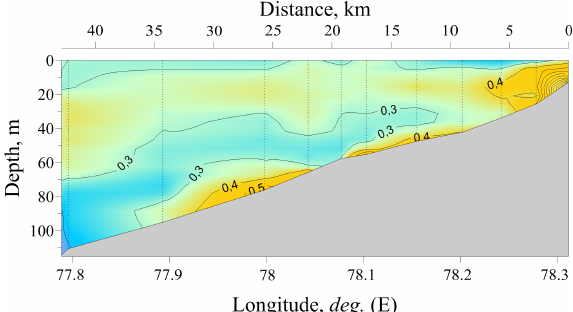
Figure 13. Vertical distribution of chlorophyll a concentration (mgm − 3 ) in a longitudinal section following the ancient bed of the Jyrgalan River on the eastern shelf on 1 November 2016. Fig. 13. The maximum concentration is observed near the shore in proximity of the river mouth. To the west of the estuary, the vertical structure of chlorophyll exhibits two maxima, one at the upper boundary of the thermocline at a depth of about 20 m and the other one near the bottom. The upper maximum of plankton activity just below the mixed layer is characteristic for the entire lake and generally co- incides with the maximum concentration of nutrients. The near-bottom maximum is likely related to downslope advec- tion of chlorophyll-rich, cold waters from the eastern shelf during cooling period as discussed in the next subsection.